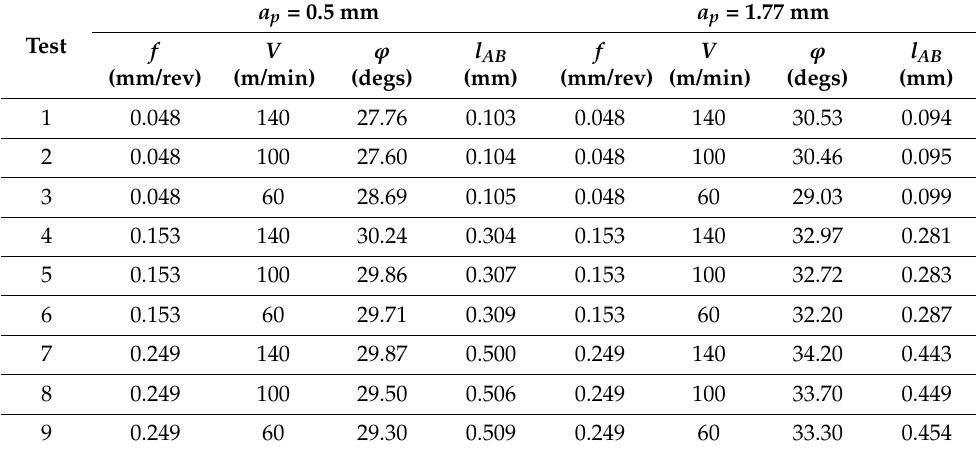
Figure 9. Impact of the cutting data on the values of the cutting force components F f and F c , a p = 1.77 mm, α = 15 ◦ . Table 8 presents the experimentally determined values of shear angle φ and the chip- edge contact length l AB. Table 8. Experimentally determined values of shear angle and shear zone length.